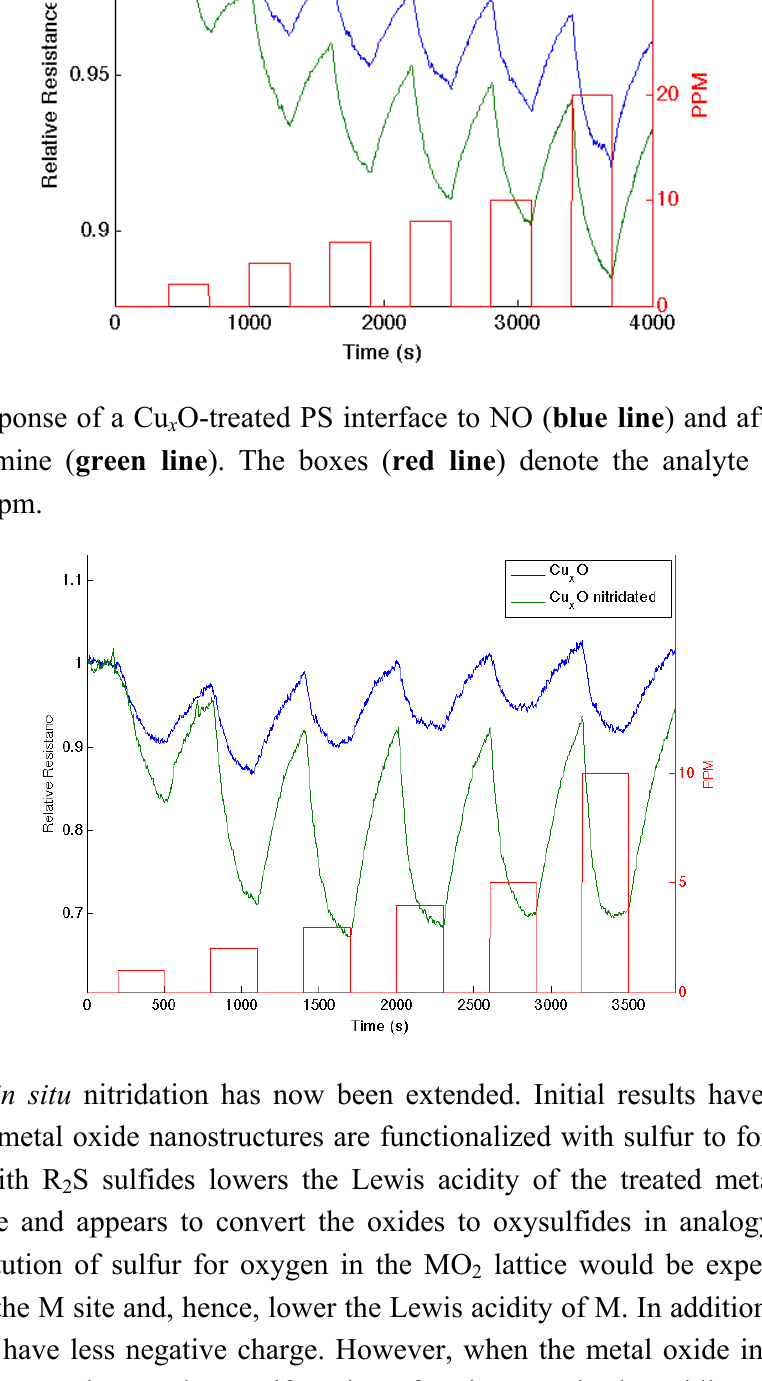
O-treated interface is basic relative to the PS- and x